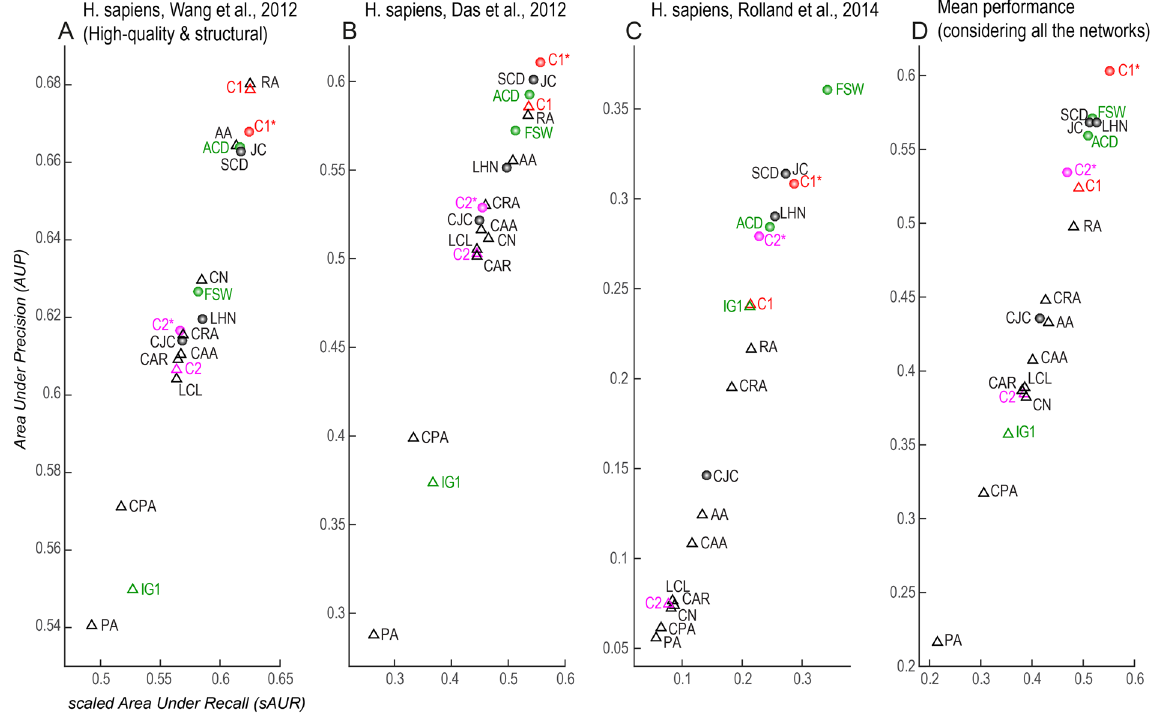
Figure 4. Performance evaluation in network 7, 8, 9. Different colours are used to distinguish: the classical network science reliability models (black); the traditional network biology models (green); the two new local- community models based on the rule C1 and its normalized version C1 * (red); the two new local-community models based on the rule C2 and its normalized version C2 * (magenta). The triangle symbol is adopted to mark the non-normalised algorithms. ( D) Mean performance of each method computed as average sAUR (x-axis) and AUP (y-axis) on the nine considered networks.